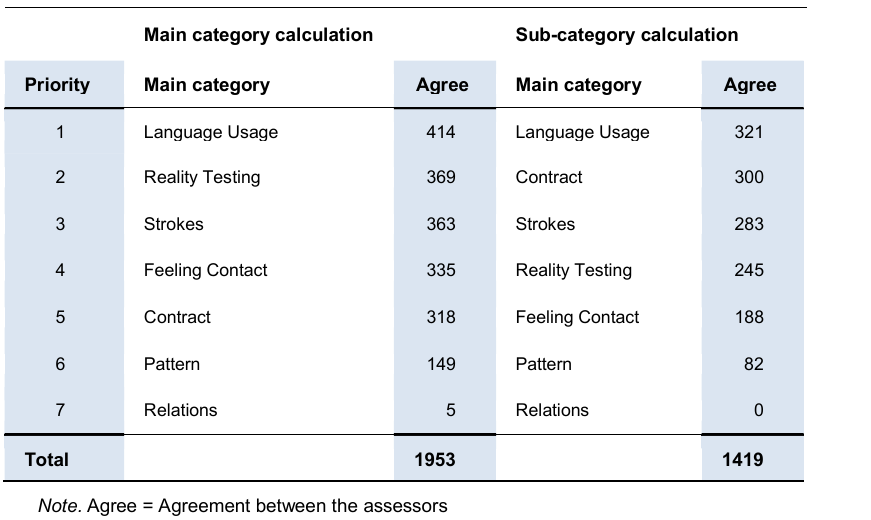
Table 2: Ranking based on the number of matching codings by main and sub-category calculation, respectively. Priority 1–7